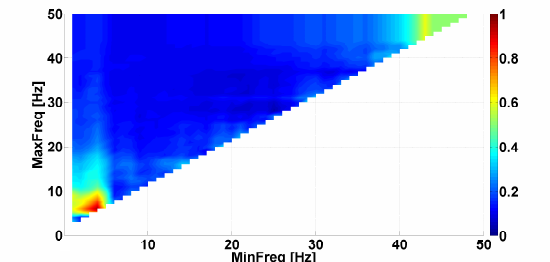
Figure 17. Example of Frequency CWS AUC diagram. The instantaneous phase of the considered cross-wave trains is constrained by the ranges from − π to − π /2 and from + π /2 to + π , that is, cross-wave trains related to the alternating tremor. Signals from the antagonist muscles in the left arm with hyperkinetic movement in PD and ET patients are considered. The abscissa axis is the lower bound of the frequency range; the ordinate axis is the upper bound of the frequency range.